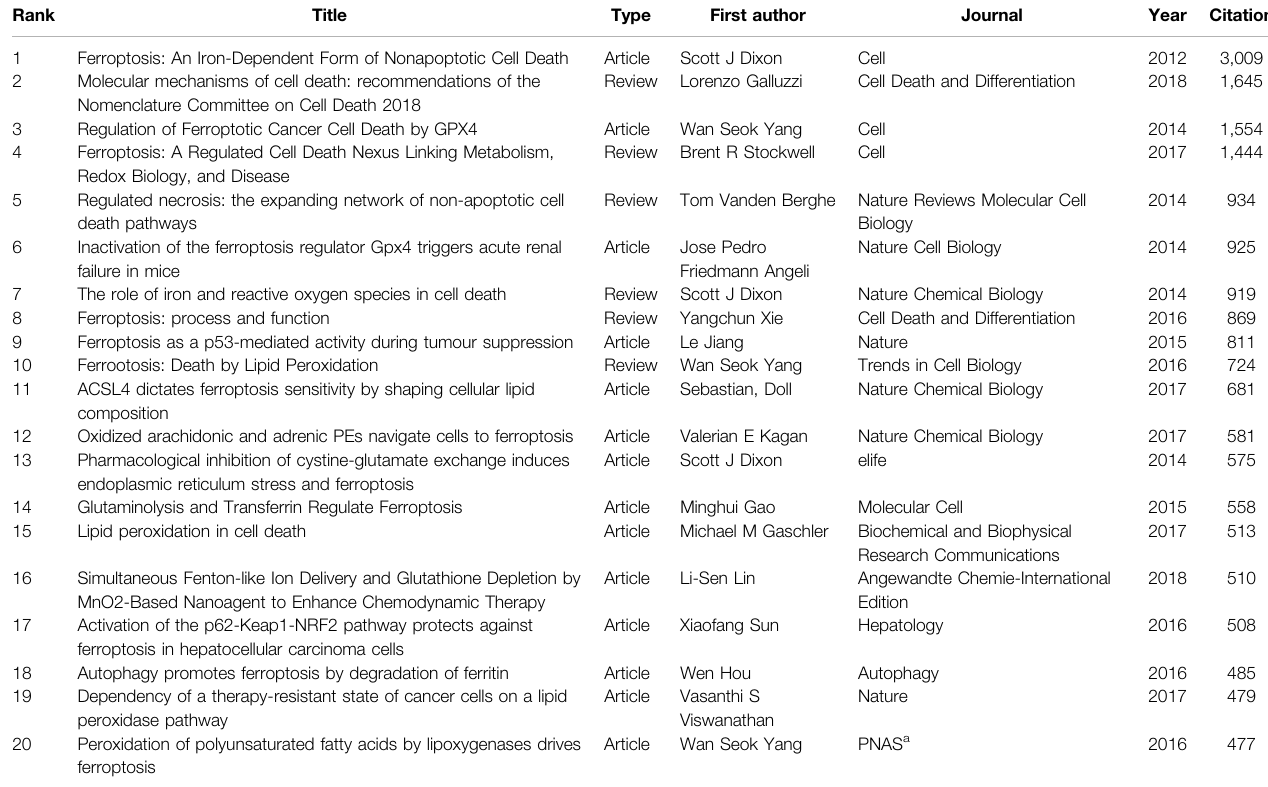
TABLE 7 | Top 20 ferroptosis-related publications in cancer with the most citations (up to 19 December